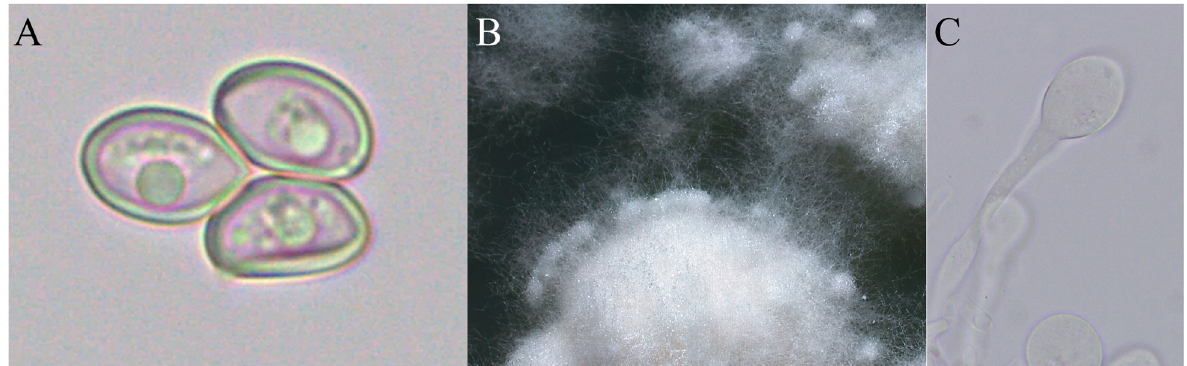
Figure 2. Leucoagaricus gongylophorus cultured from basidiospores. ( A ) Basidiospores obtained from a basidiome collected on 21 February 2020 in Rio Claro-SP, Brazil (Colony ID: RB200507-03). ( B ) Fungal mycelium on potato dextrose agar me- dium after incubating for 30 days at 25 °C showing typical growth pattern for L. gongylophorus with staphylae (clusters of gongylidia) at the edge. ( C ) Gongylidia (i.e., specialized hyphal tip swellings) found in the cultured mycelium.